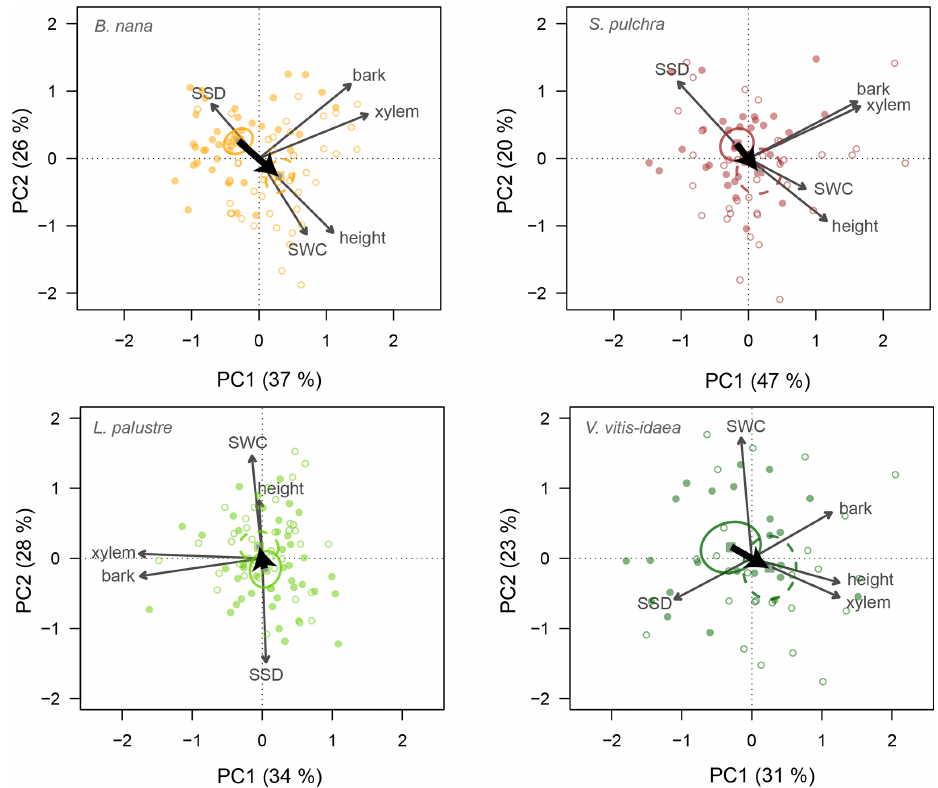
Figure 4. Principal component biplots of plant height and stem traits for each shrub species. Stem traits included are xylem diameter, bark thickness, stem water content (SWC) and stem-specific density (SSD). Change in traits when nutrients are added is shown by thick black arrows. Points are the trait scores of individuals without fertilization (closed circles) and with fertilization (open circles). Sample scores are scaled by a factor of 15, and variable loadings by a factor of 7. Squares indicate the centre of the ordiellipses (standard error with 95% confidence interval) of the trait scores without nutrient addition (solid lines) and with nutrient addition (dashed lines). The total variance explained by the two first principal components (PC1, PC2) is indicated as a percentage between brackets on the